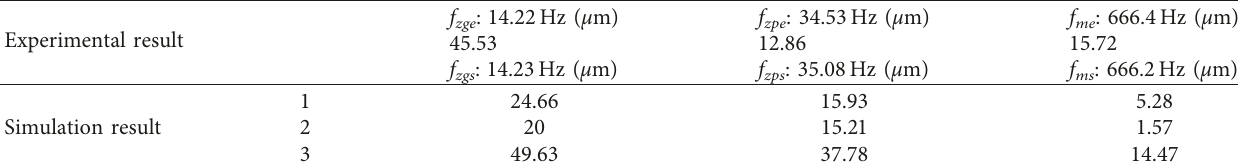
Table 6: The amplitudes corresponding to the fundamental frequencies in experimental and simulation results at 2104rpm.